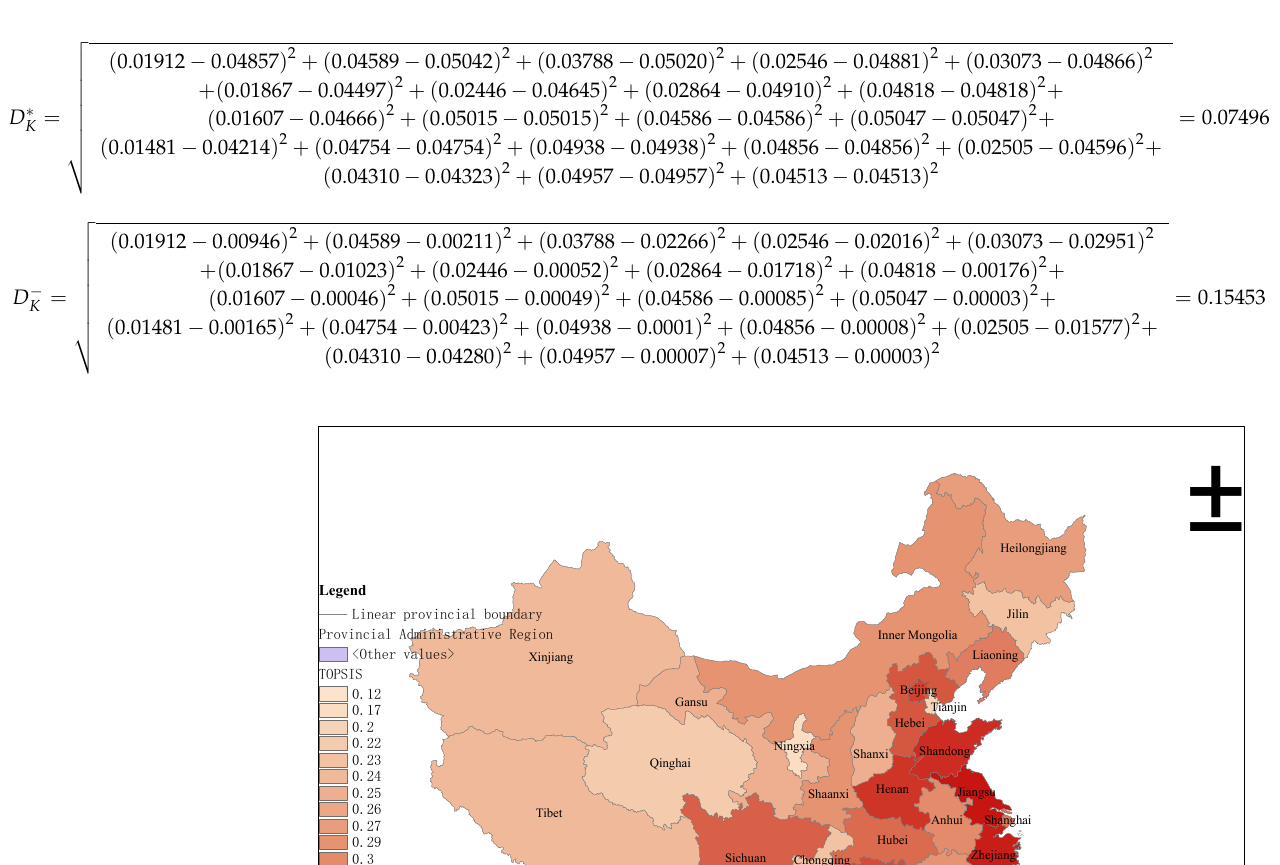
Table 9. The TOPSIS data of Guangdong Province.